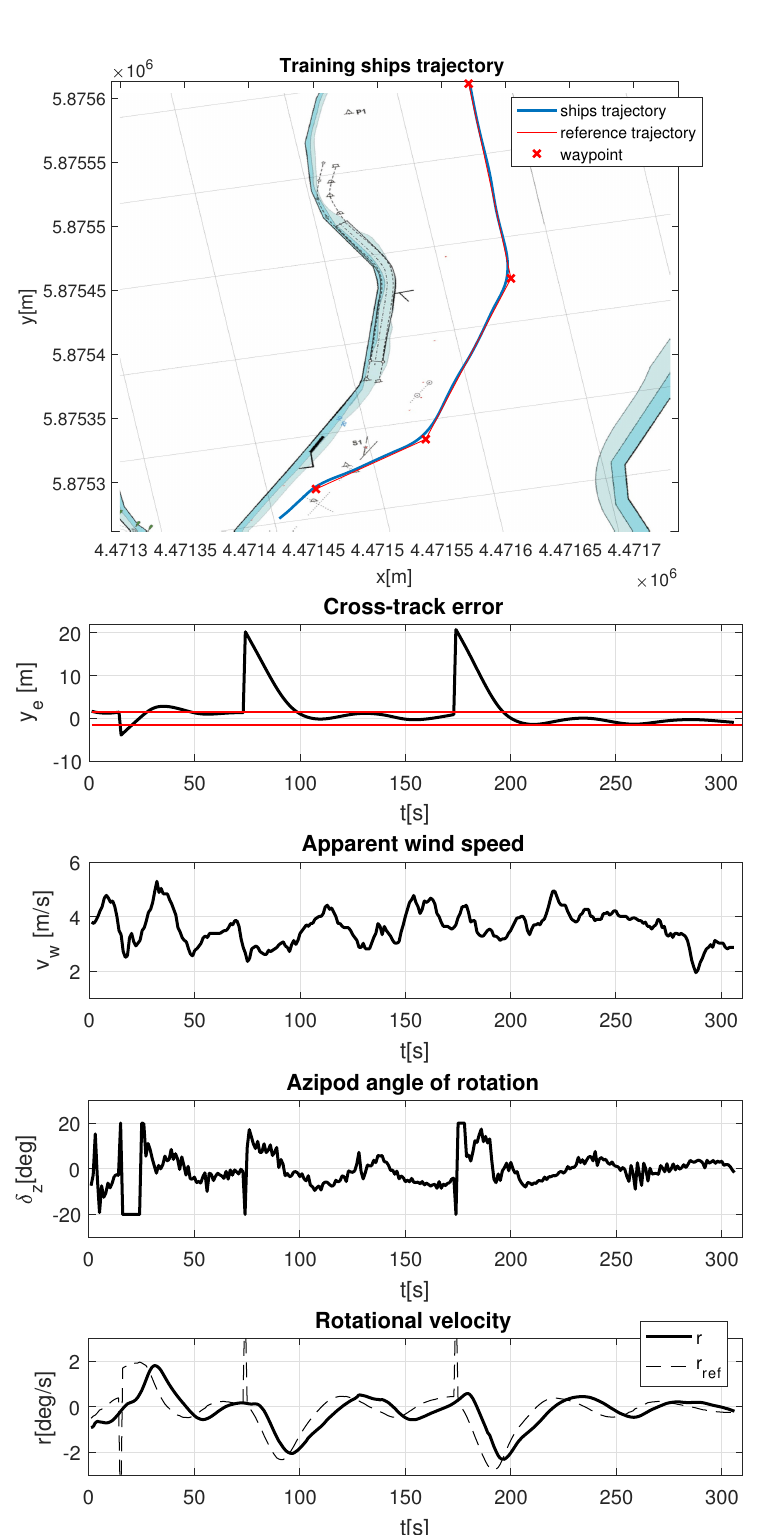
Figure 10. “Dorchester Lady” model MPC–LOS trajectory tracking. Upper part: Reference (red line) and measured (blue line) trajectories of the training ship, waypoints (WPTs) (marked by cross). Lower part: recorded signals marked with following symbols: y e , v w , δ z , r , r ref —cross-track error (“–” sign indicates that ship has reference trajectory on the port side), apparent wind speed, azipod angle of rotation (“–” sign indicates thet azipods are rotated to the port side), rotational velocity (“–” sign indicates counterclockwise rotation), and reference rotational velocity, respectively; reference rotational velocity is marked with dashed